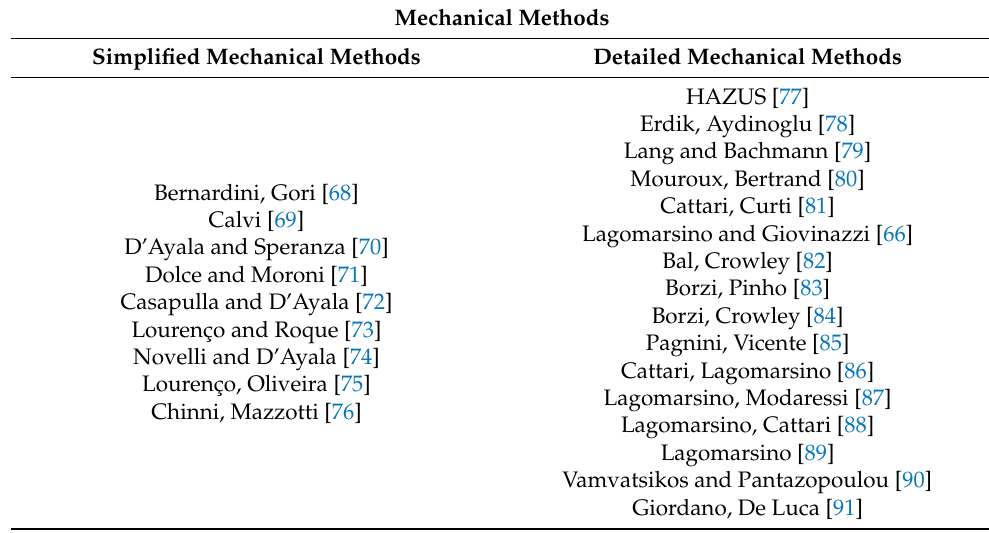
Table 2. Summary of different proposals for the mechanical analysis of masonry